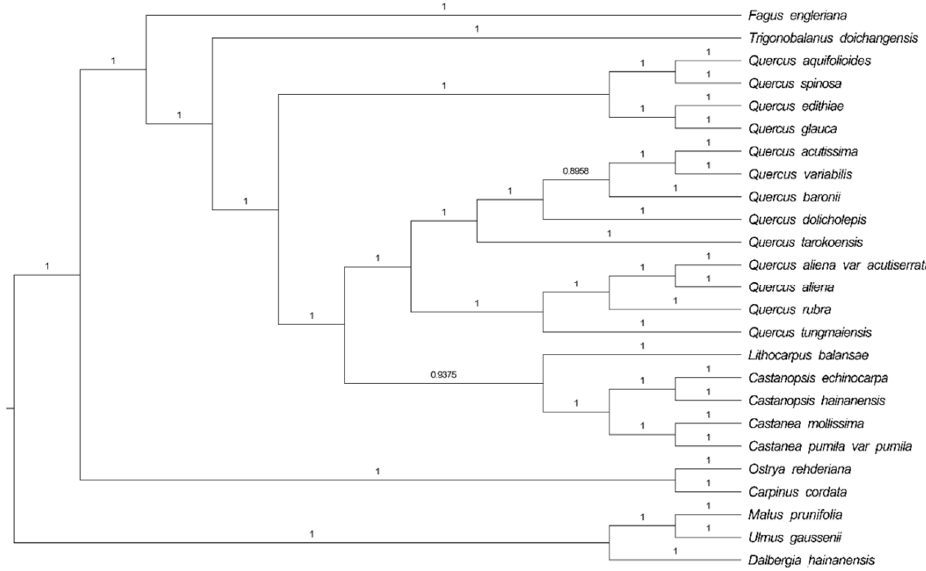
Figure 4. Bayesian inference (BI) phylogenetic tree reconstruction including 25 species based on all chloroplast genomes. Malus prunifolia and Ulmus gaussenii were used as the outgroup.